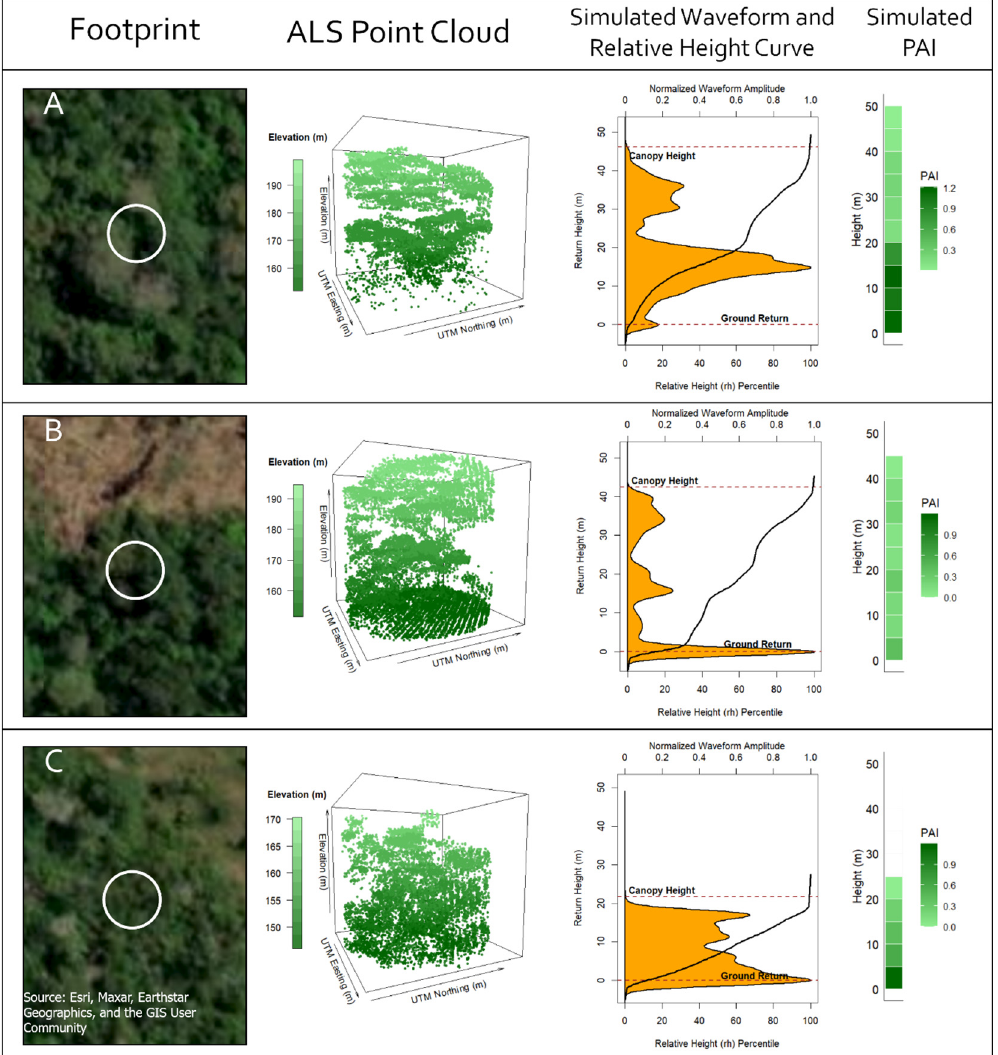
Figure 3. ALS footprint of 25 m, with corresponding simulated GEDI waveform (orange), relative height curve (black line), and PAI values for three different sites. Arial imagery provides insights into the condition of each footprint. Row A represents interior, largely undisturbed forest. Row B shows a footprint at the forest edge (abutting an agricultural field) with tall emergent trees, but the density of plant growth is thinned out by disturbance. Row C is a relatively short, young forest with dense regrowth near the forest